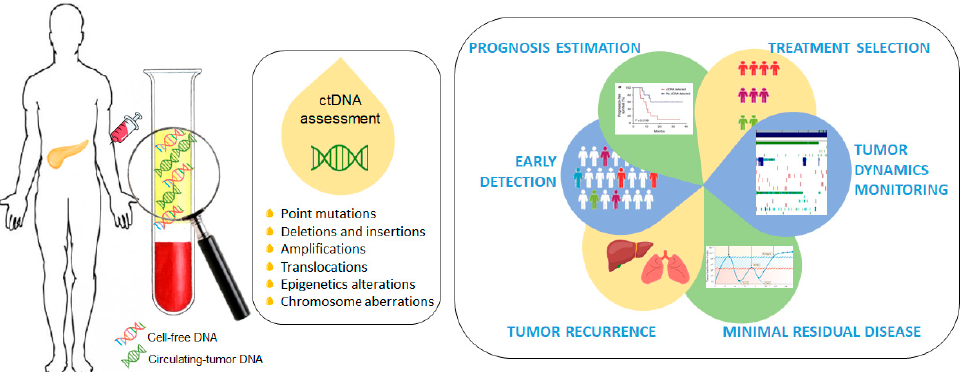
Figure 1. Circulating-tumor DNA (ctDNA) as a promising non-invasive blood-based biomarker in cancer management. Quantitative detection of ctDNA is based on the identification of various tumor-specific genetic or epigenetic aberrations in plasma cell ‐ free DNA (cfDNA) samples.